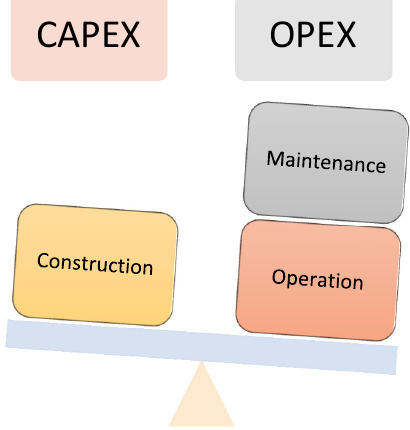
Figure 3. Schematic view of CAPEX versus OPEX.